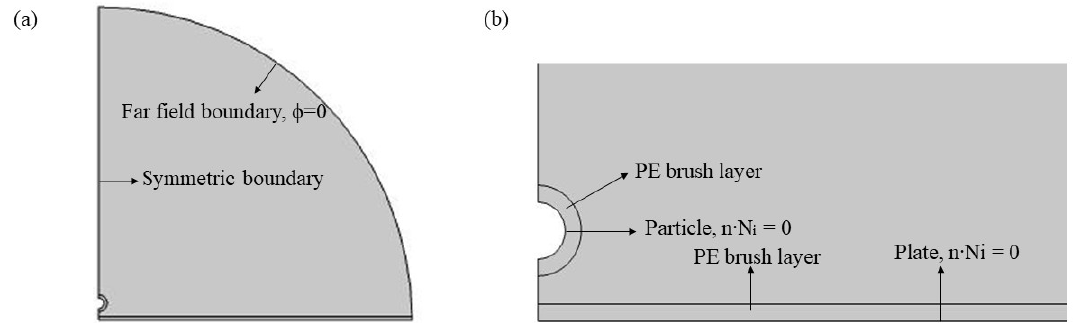
Figure A1. The structure diagram of the model in software, ( a ) structural integrity, ( b ) local